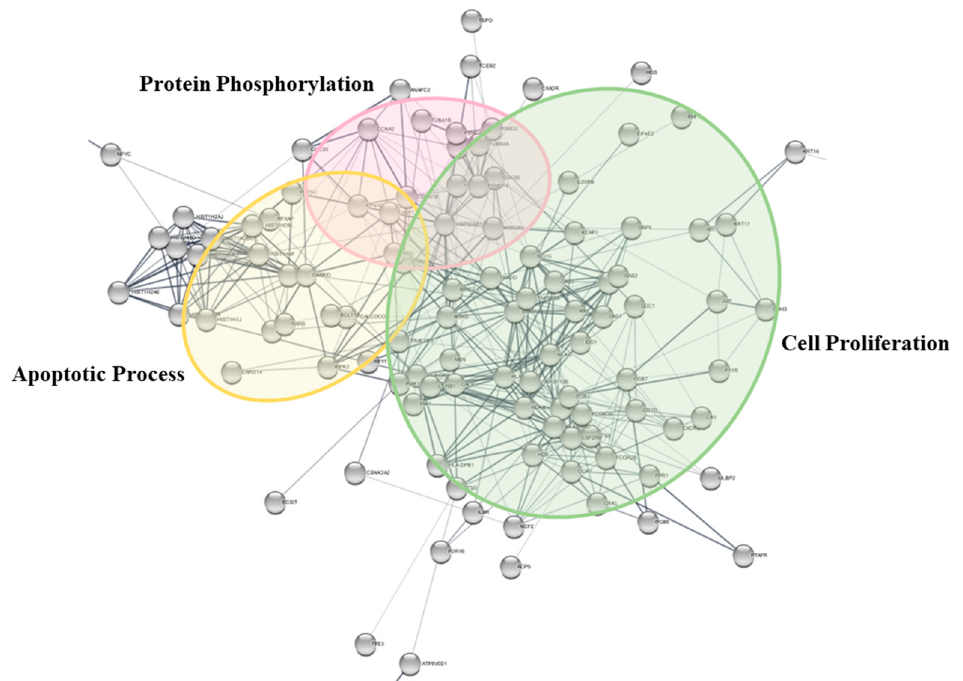
Figure 4. BP clusters of 133 upregulated DEGs overlapped with IMPAGT. When PPI network was clustered with BP traits, it presented a tendency to cluster into three groups: “Apoptotic process,” “Protein phosphorylation,” and “Cell proliferation”.